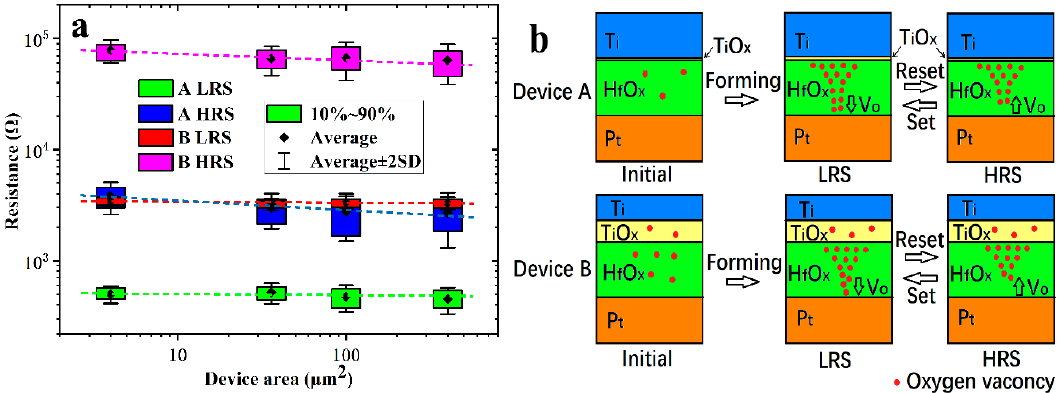
Figure 6. ( a ) Device area dependence of resistance of 10 nm HfO x devices and ( b ) schematic description of the resistive switching mechanism.